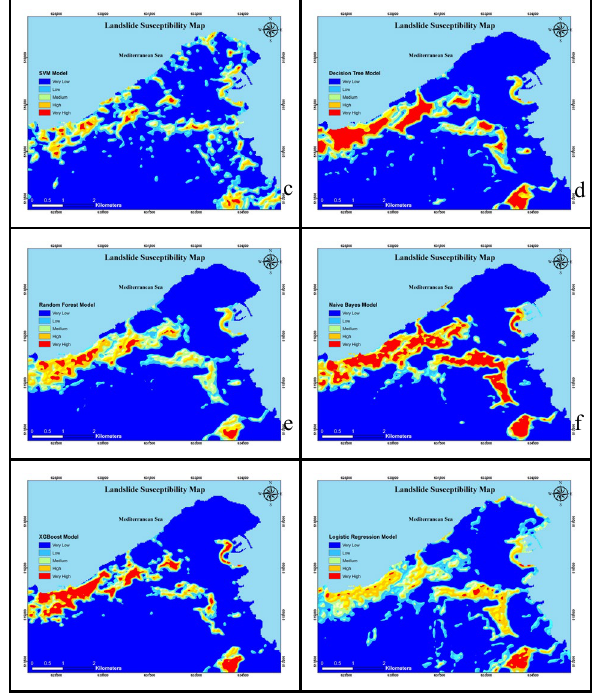
Figure 9. Landslide susceptibility map produced from Machine Learning algorithms after Undersampling: (a) SVM; (b) Decision Tree; (c) Random Forest; (d) Naïve Bayes; (e) XGBoost; (f) Logistic